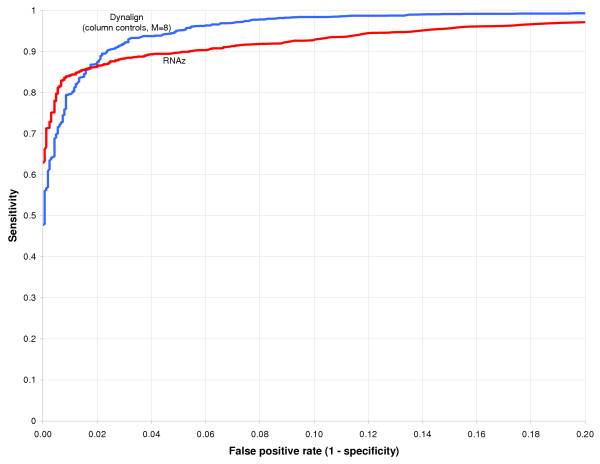
Comparison of the Dynalign z score method with RNAz for sequence pairs of all identities. ROC curves for the Dynalign z score classification method (running 20 controls for each input sequence pair to determine z score, M = 8; blue) and RNAz (red), both tested on the same test set of sequence pairs as in Figure 3.